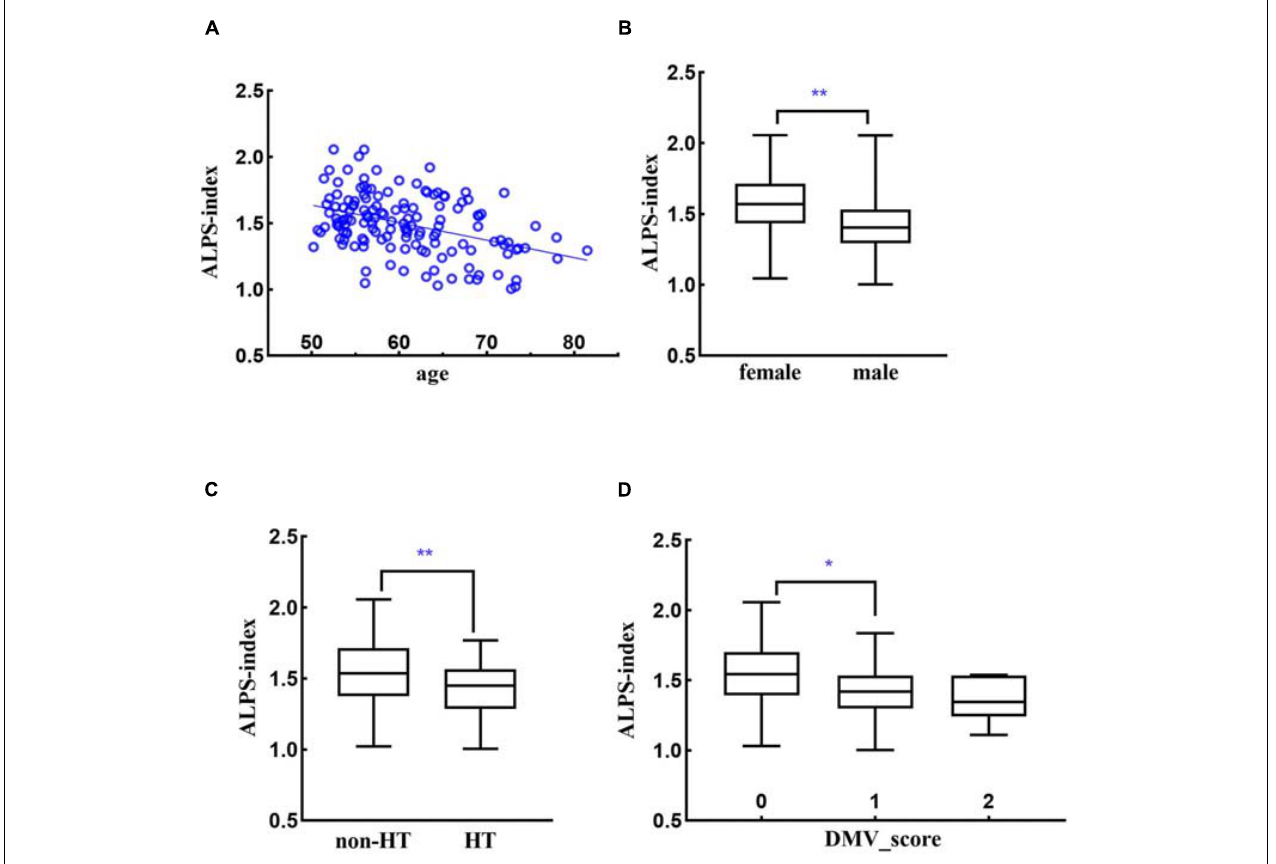
FIGURE 3 | Relationships between ALPS-index and age (A) , sex (B) , hypertension [HT, (C) ], and DMV score (D) . * p < 0.05, ** p < 0.001.